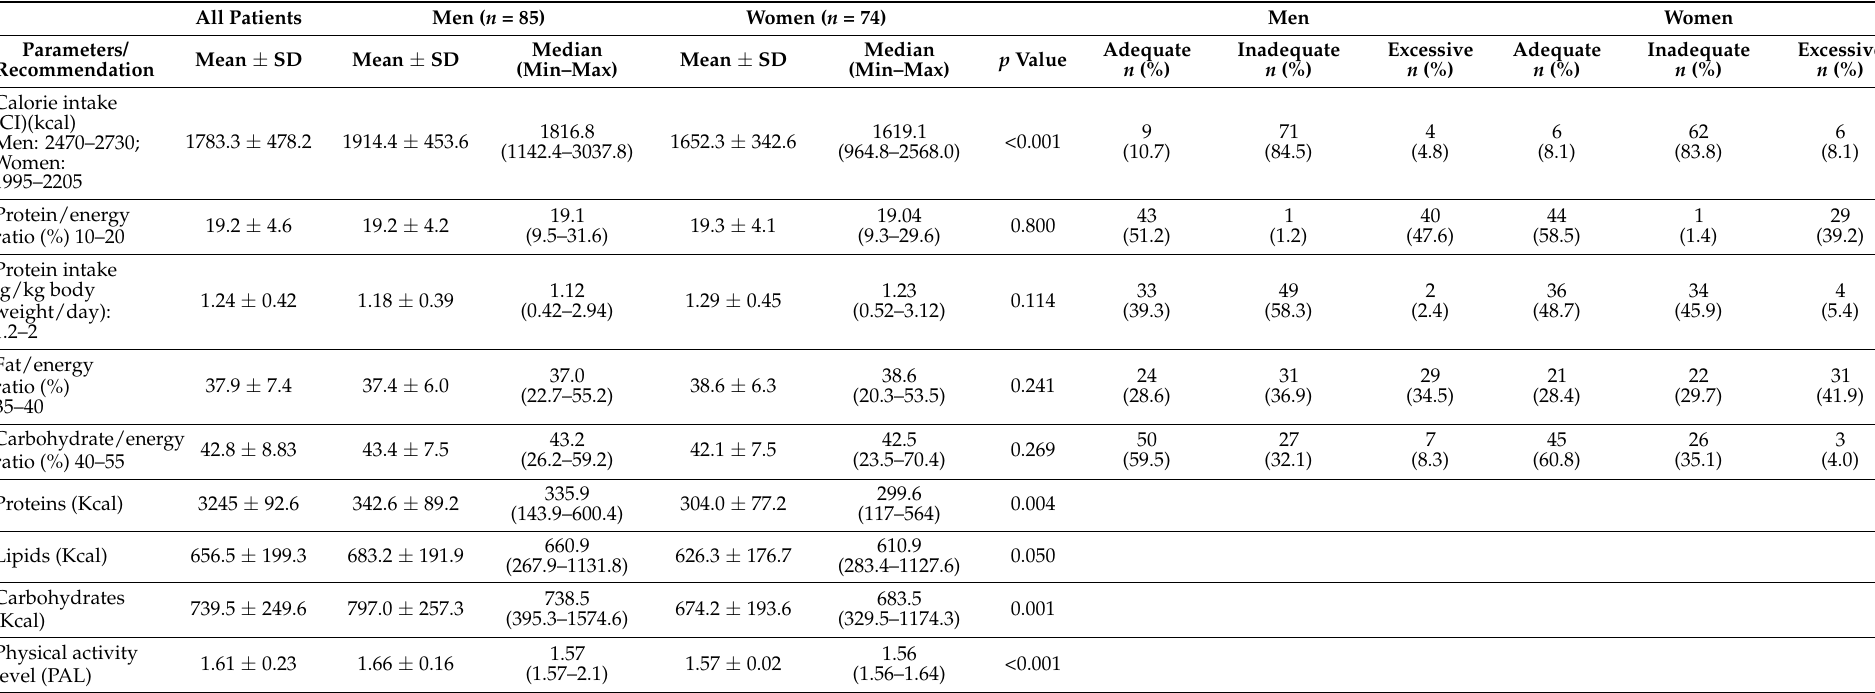
Table 3. Energy and macronutrient energy intake and intake adequacy analysis in patients with